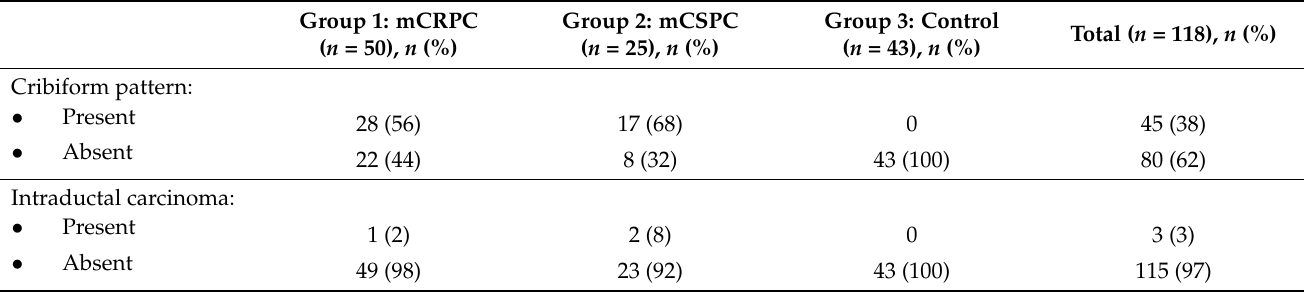
Table 3. Prevalence of cribriform pattern and intraductal carcinoma in the histologically reviewed